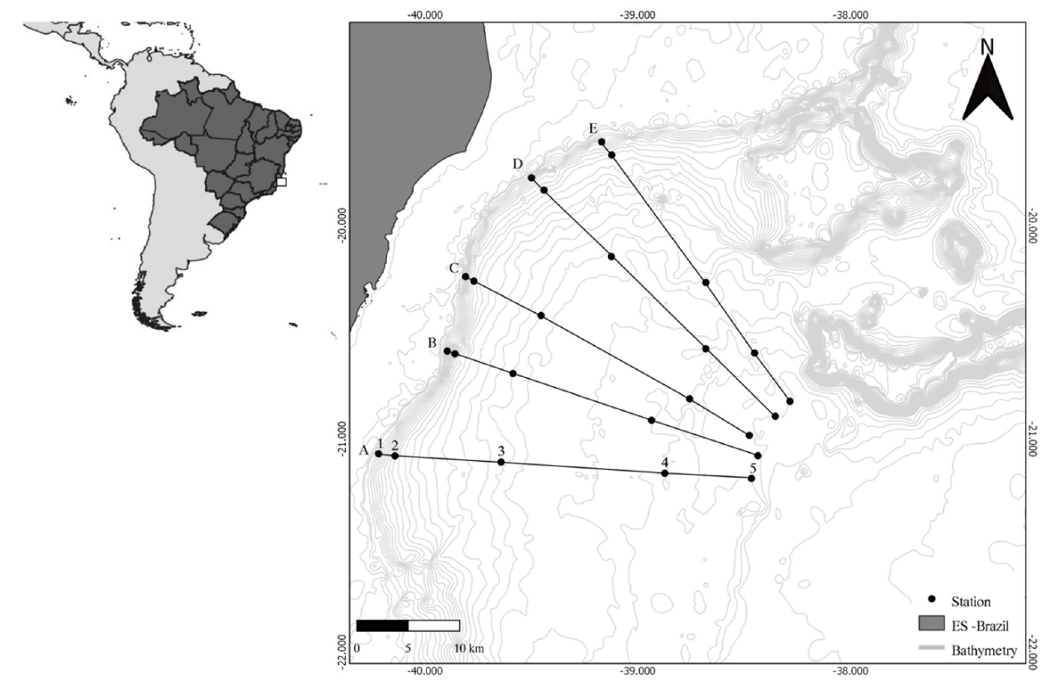
Figure 1. Bathymetric map of the sampling area in the Espírito Santo (ES) Basin, with the five bathymetric transects ( A – E ), each with stations at five different depths: 400 m (1); 1000 m (2); 1900 m (3); 2500 m (4) 3000 m (5) (Qgis Software 3.4.4.).